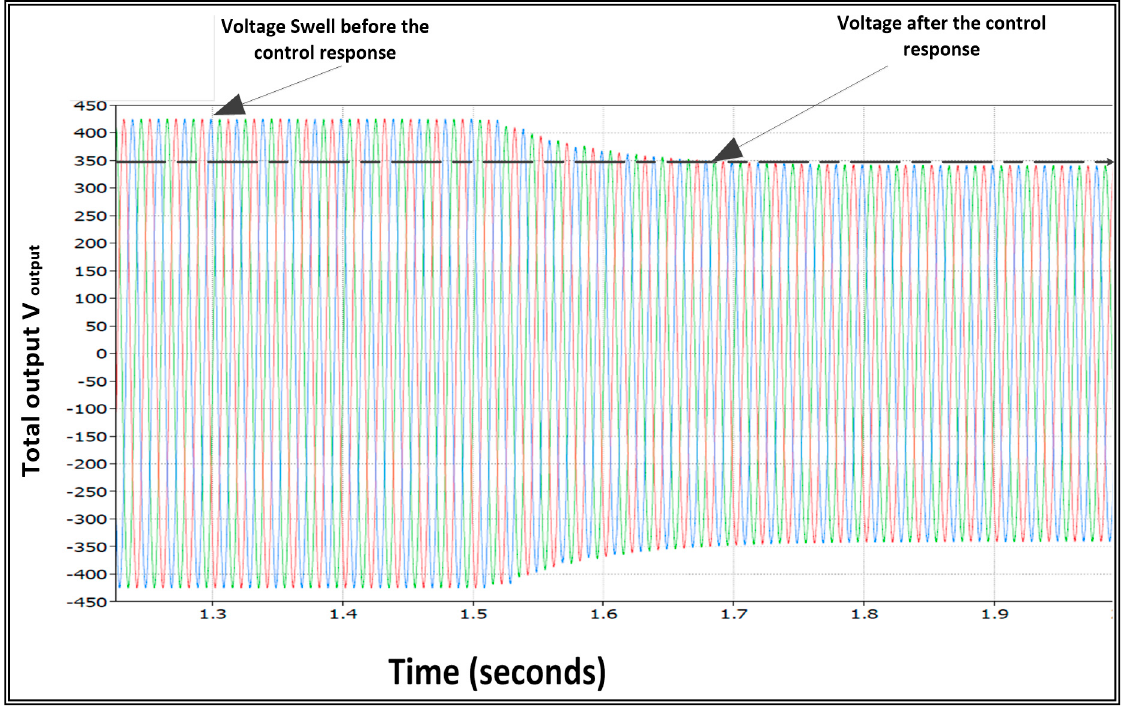
Figure 17. The overall control response to a voltage swell.